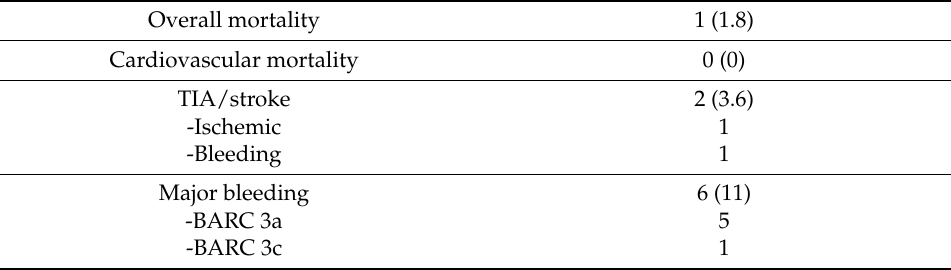
Table 5. Adverse events during 12-month follow-up ( n = 54). Overall mortality 1